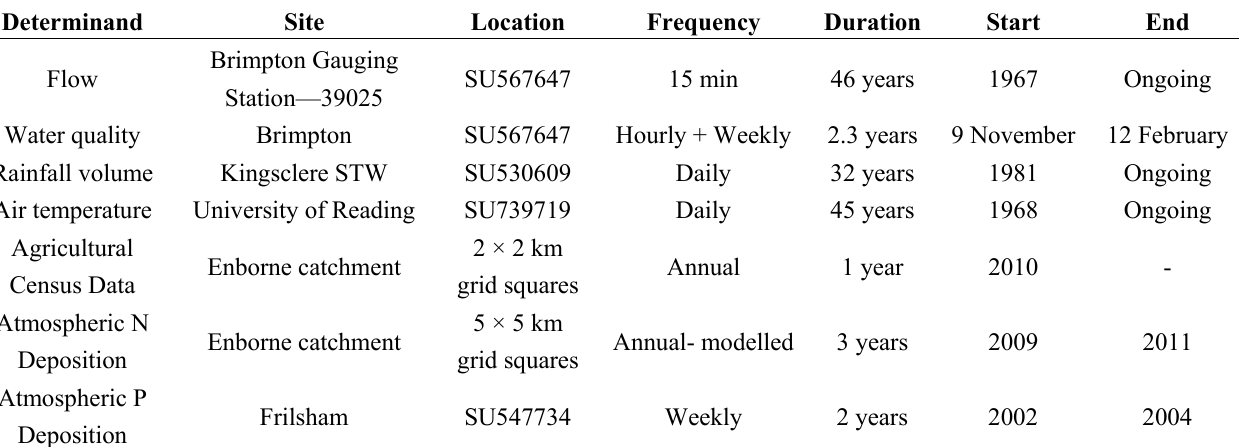
Table 1. Sources of data for this paper.